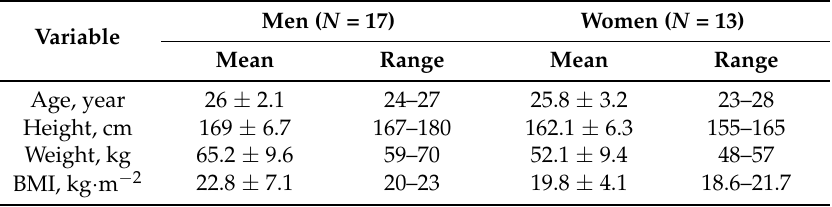
Table 1. Physical characteristics of the participating subjects ( N =